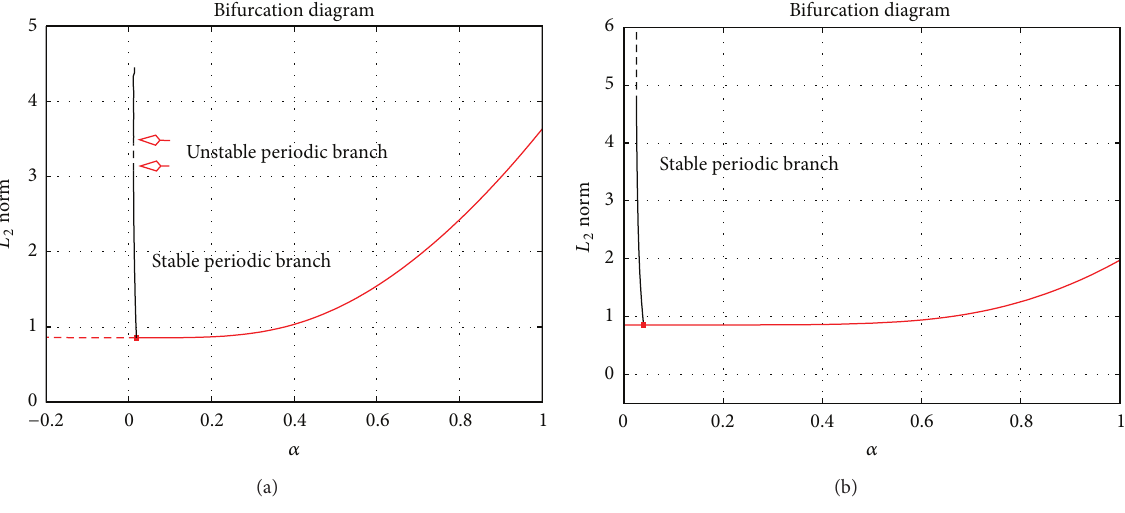
Figure 3: Case 2. (a) 𝑚 = 1 , (b) 𝑚 = 2